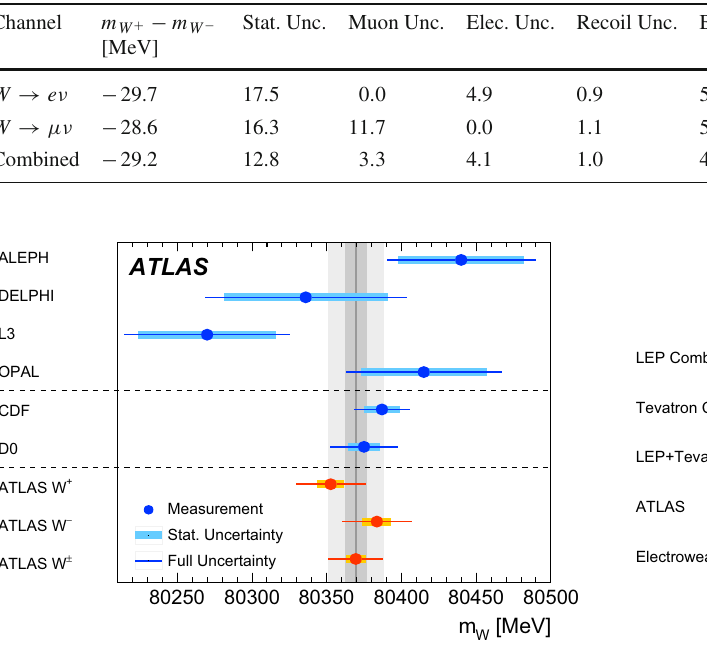
Table 13 Results of the m W + − m W − measurements in the electron and muon decay channels, and of the combination. The table shows the statistical uncertainties; the experimental uncertainties, divided into muon-, electron-, recoil- and background-uncertainties; and the mod-